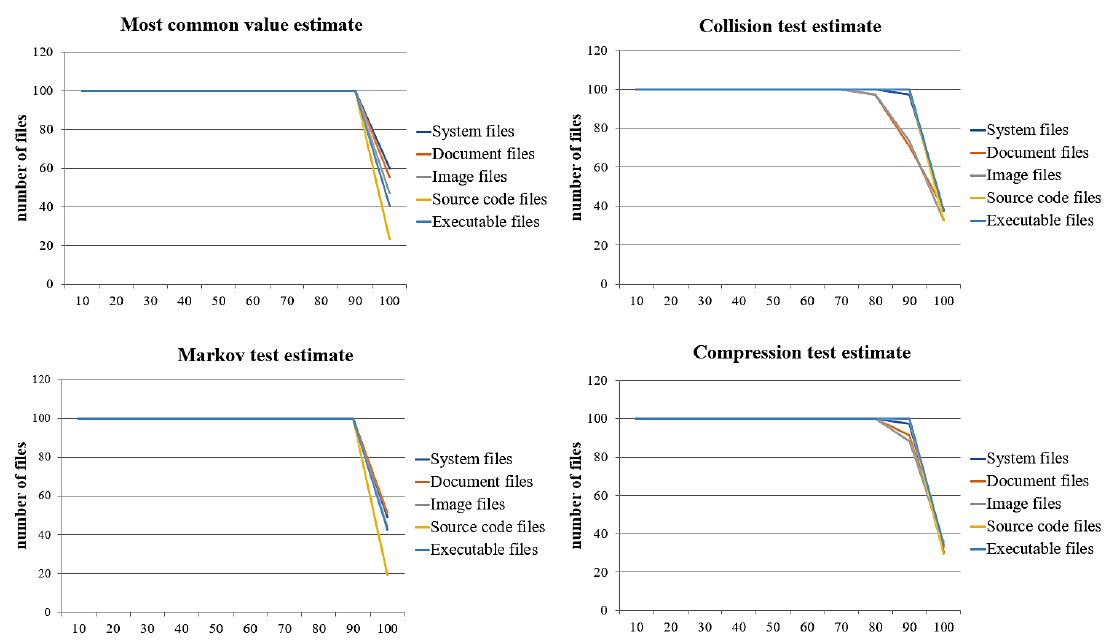
Figure 8. Average detection rate based on entropy average per 10 files infected by ransomware.